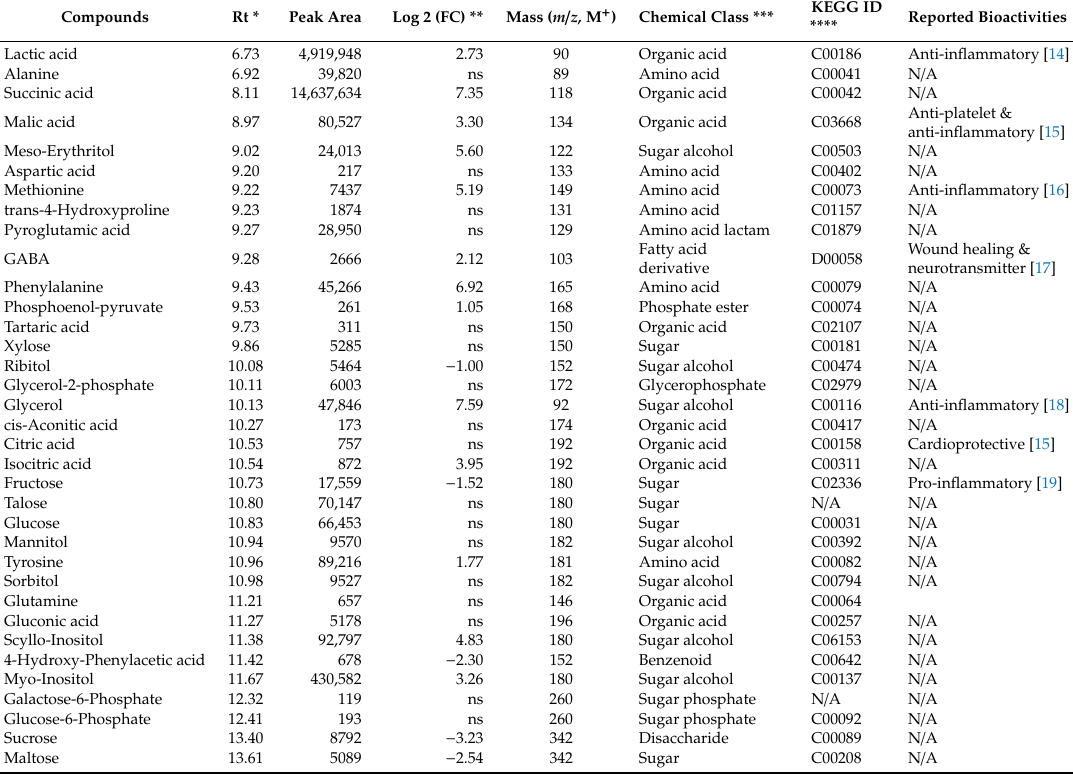
Table 1. Total polar small molecule (SM) identified by gas chromatography mass spectrometry (GC-MS) from the excretory-secretory products (ESP) of D. caninum with their molecular characteristics. Compounds Rt * Peak Area Log 2 (FC) ** Mass ( m / z, M + ) Chemical Class *** KEGG ID **** Reported Bioactivities Lactic